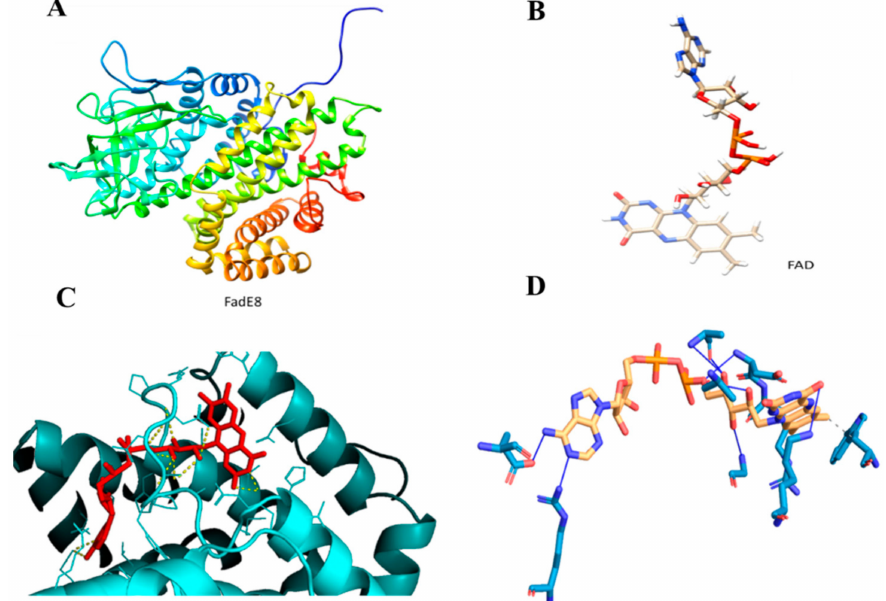
Figure 7. ( A ). FadE8 model obtained with I-TASSER Server. ( B ). Flavin adenine dinucleotide (FAD) model obtained with the LigParGen Server. ( C ). Zoom image of the FadE8 / FAD model. The protein is shown in cyan while the ligand is shown in red. ( D ). Predicted interactions between FadE8 and the FAD ligand using the Protein-Ligand Interaction Profiler (PLIP) Server.